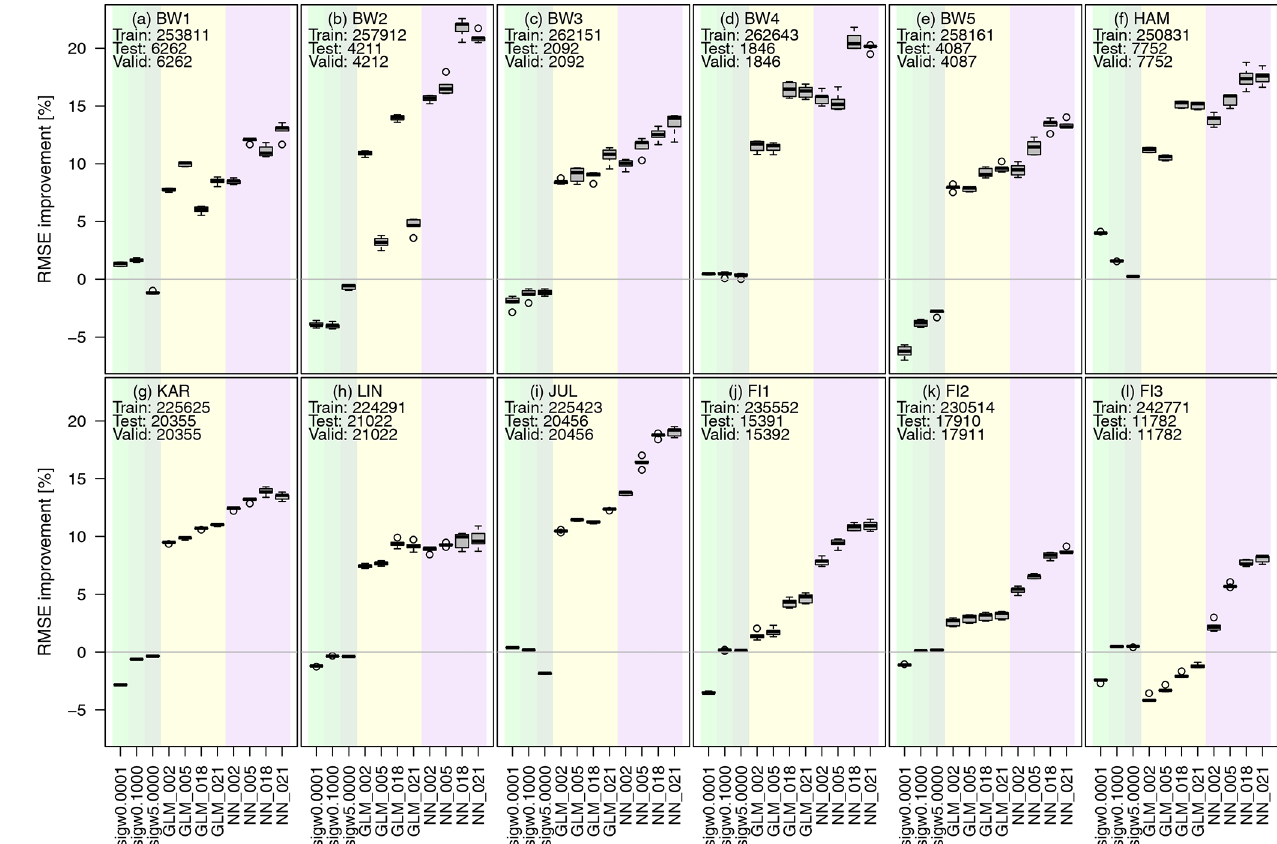
Figure 5. As Fig. 4 but now with the training data set of 11 observation sites and the test and validation data set of the site left out.